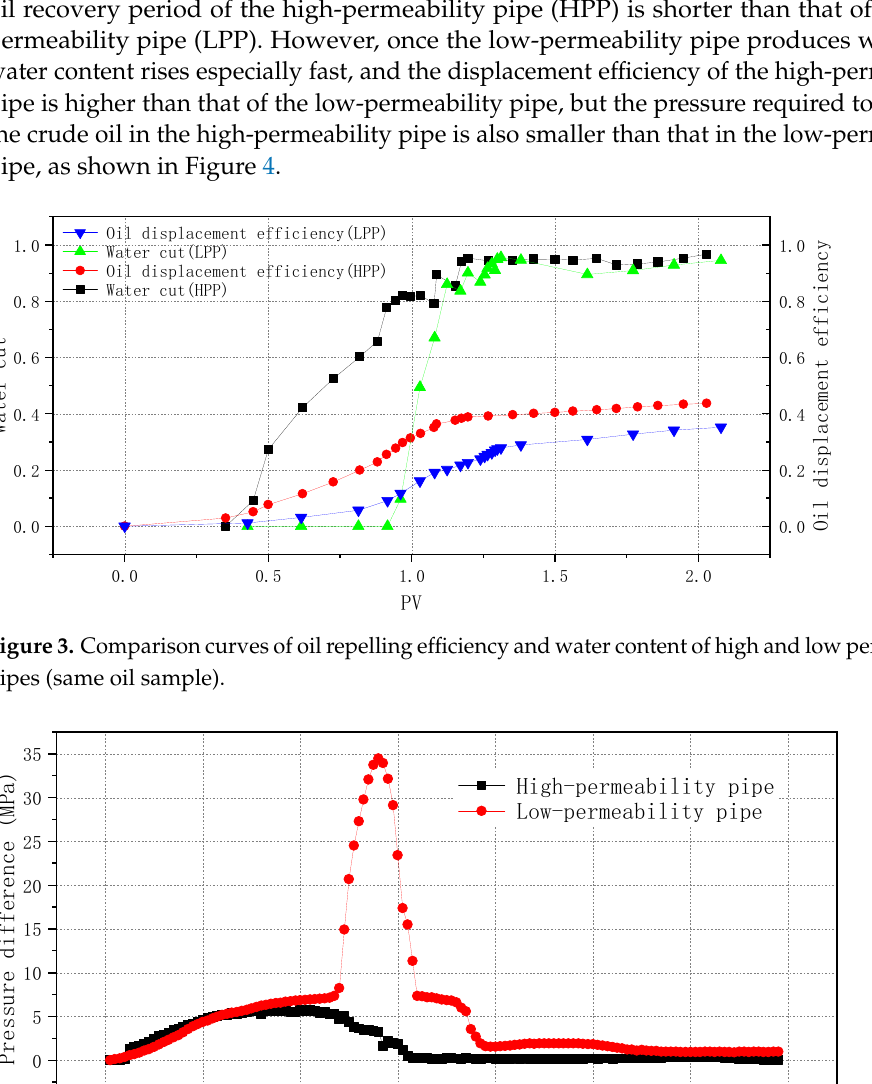
Figure 2. Displacement efficiency of two different compound oil.